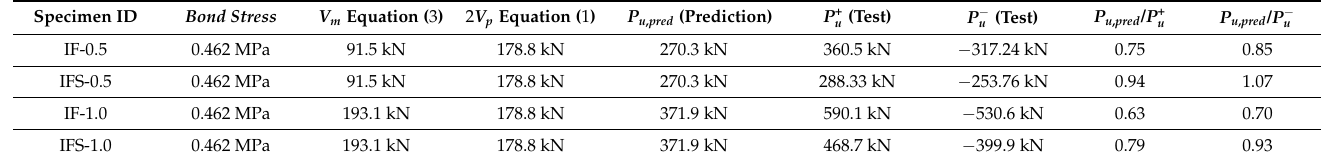
Table 5. Prediction of maximum force by ASCE